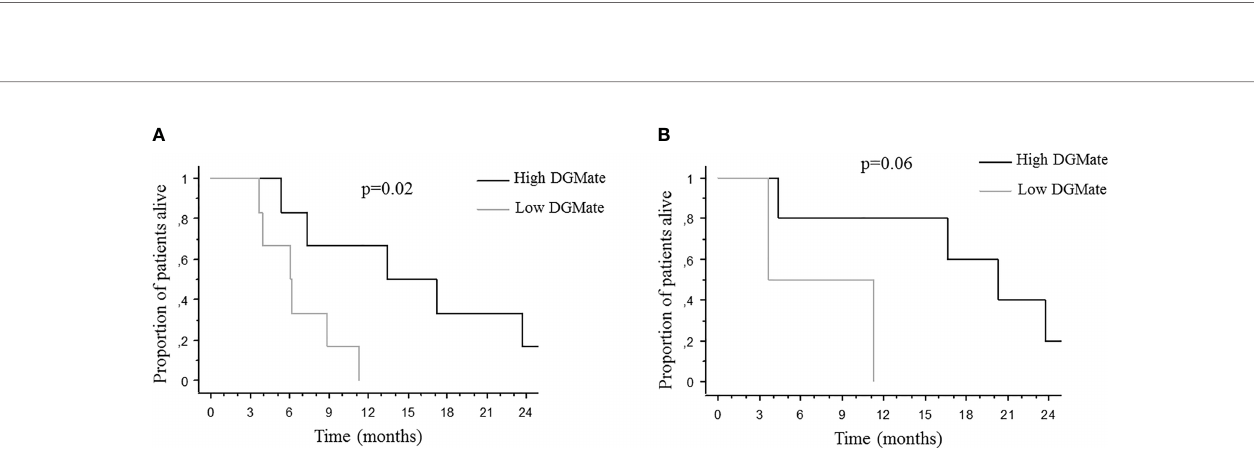
FIGURE 4 | Median overall survival after brain metastases diagnosis according to DGMate score (A) , CD3 in fi ltrating T-cells (B) , CD8 in fi ltrating T-cells (C) , and PDL1 positive tumors (D) in primary tumor. Kaplan-Meier method was used to determine OS. DGMate, CD3 and CD8 scores were split at median and p valuecalculated using the Logrank test.